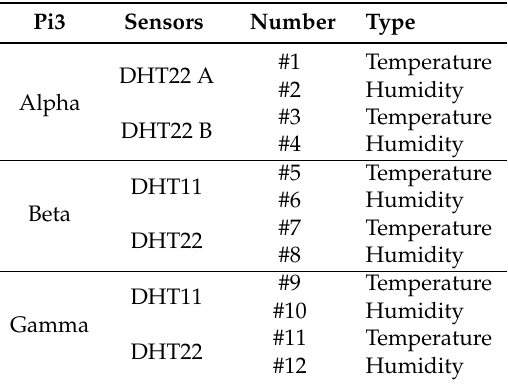
Table 4. Test bed sensors names and types.